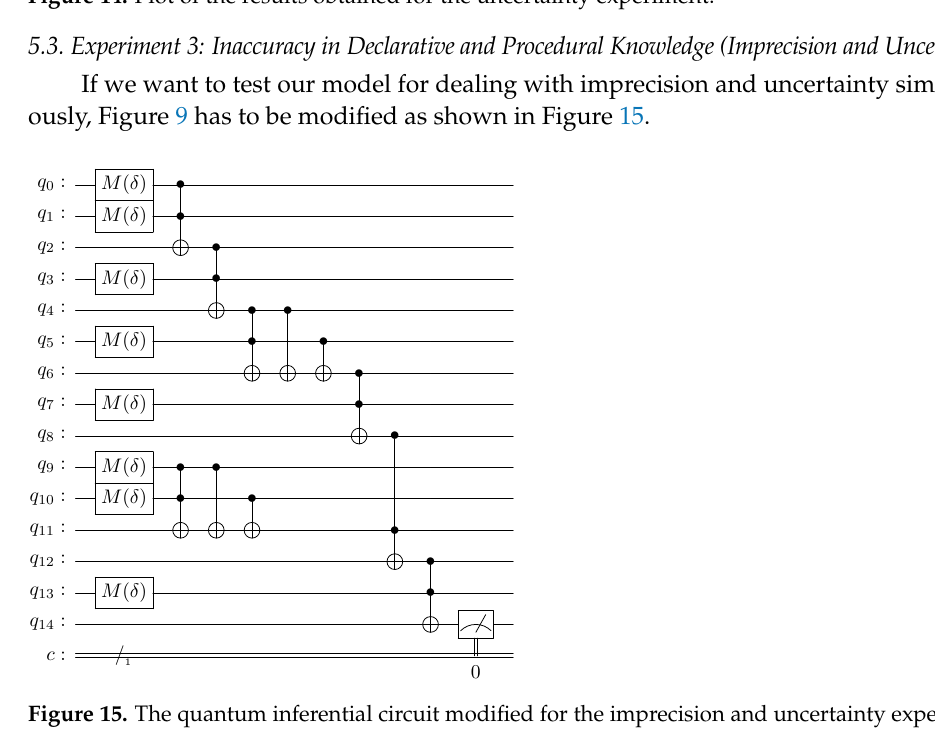
Figure 14. Plot of the results obtained for the uncertainty experiment.